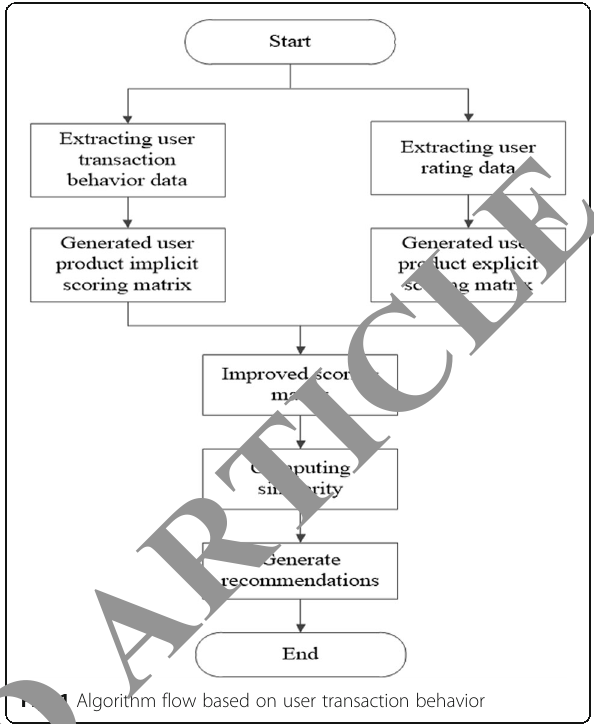
Fig. 1 Algorithm flow based on user transaction